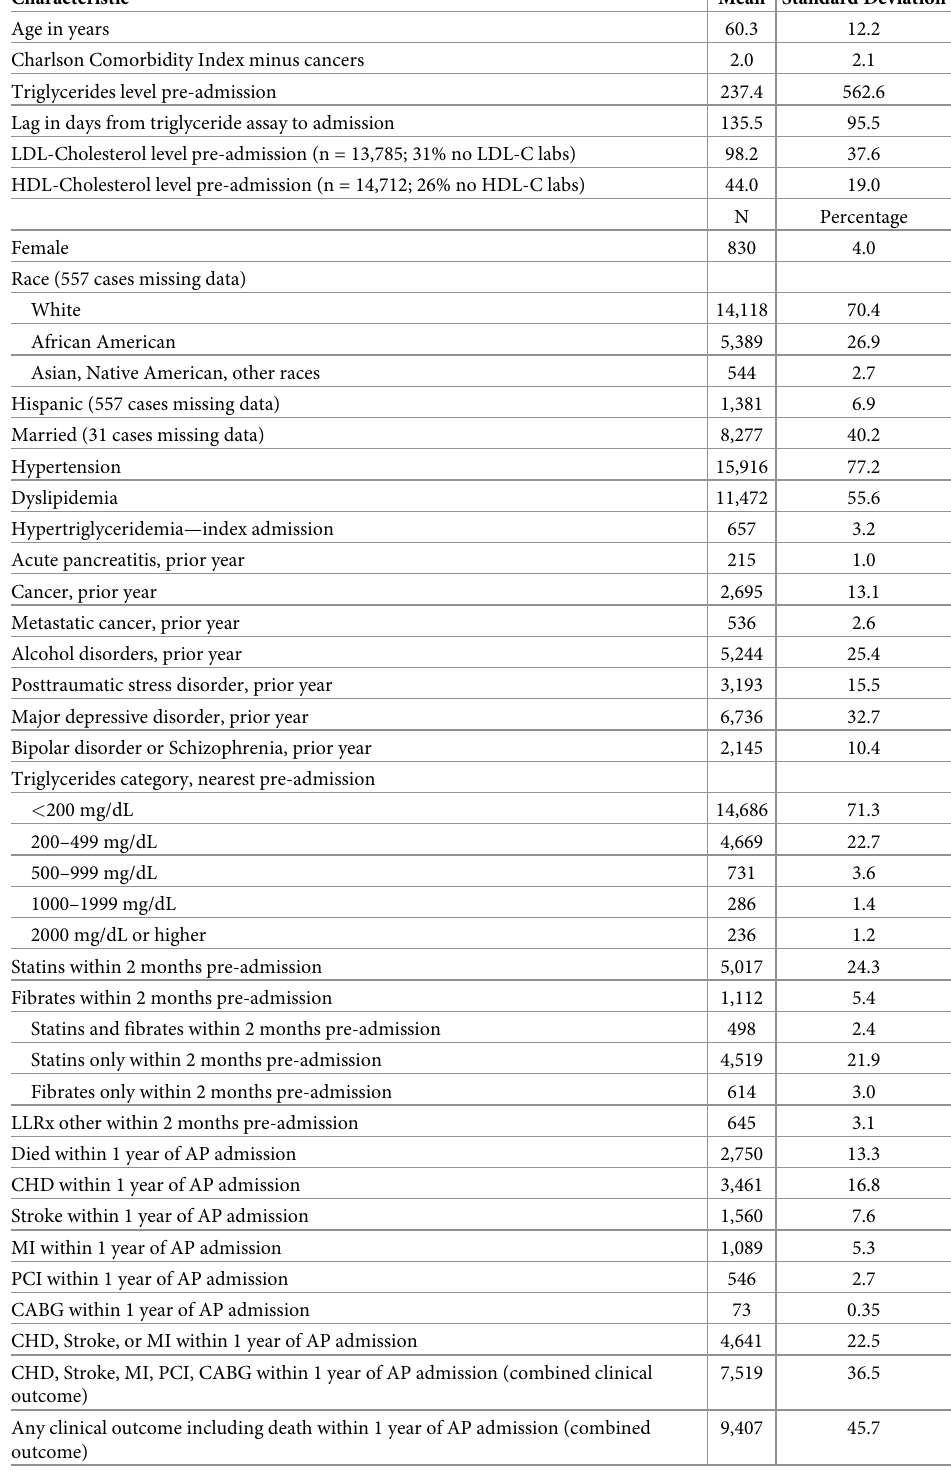
Table 1. Characteristics of VA patients admitted with acute pancreatitis FY2006-FY2009 (n =